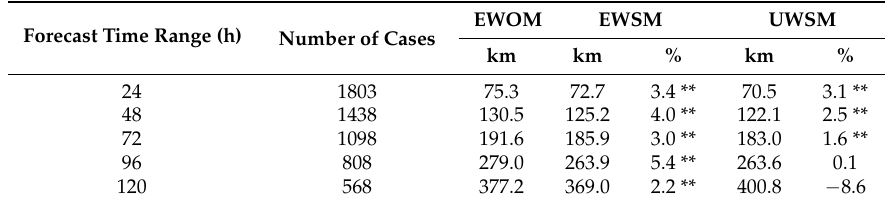
Table 2. Mean track forecast errors (km) of three different experiments for MME during 2012–2015. The EWSM (UWSM)’s skill scores (%) is relative to EWOM (EWSM).